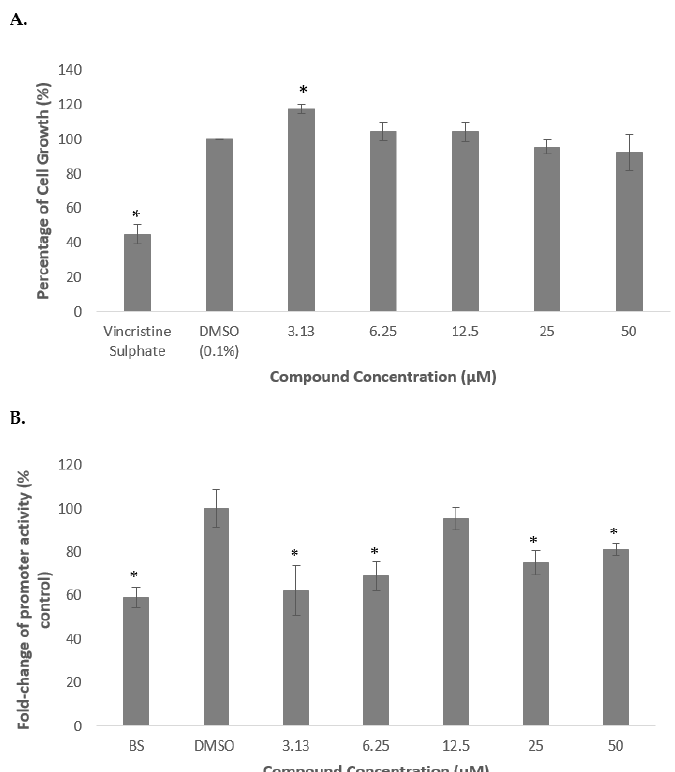
Figure 5. Percentage of cell growth of HepG2 cells after the treatment with deoxythymidine for 72 h ( A ). Luciferase activity of HepG2 transfected with PCSK9 promoter-reporter construct after 24 h treatment with deoxythymidine ( B ). The cells were treated at various concentrations from 3.13 to 50 µ M. Data presented as mean ± SD with n = 6. The values were compared to the negative control. * denotes significantly different as compared to DMSO-treated cells (negative control) at p < 0.05. DMSO was used as the carrier to dissolve and dilute the